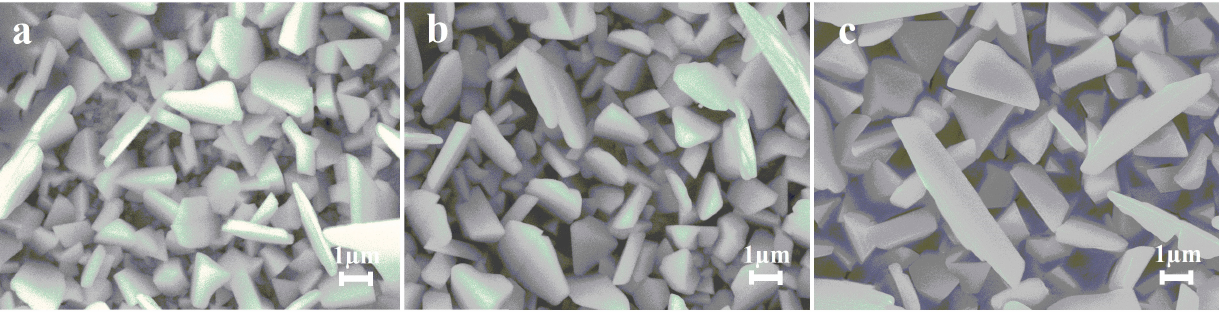
Figure 4. SEM images of the synthesized copper particles obtained at − 5 A m − 2 and KBr concentra- tion of 1 g L − 1 for 3 min ( a ), 7.5 min ( b ), and 15 min ( c ).